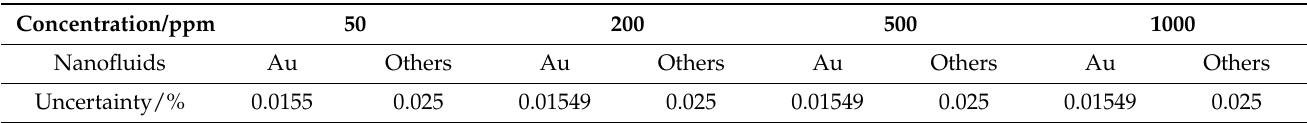
Table 1. The uncertainty of nanofluids.